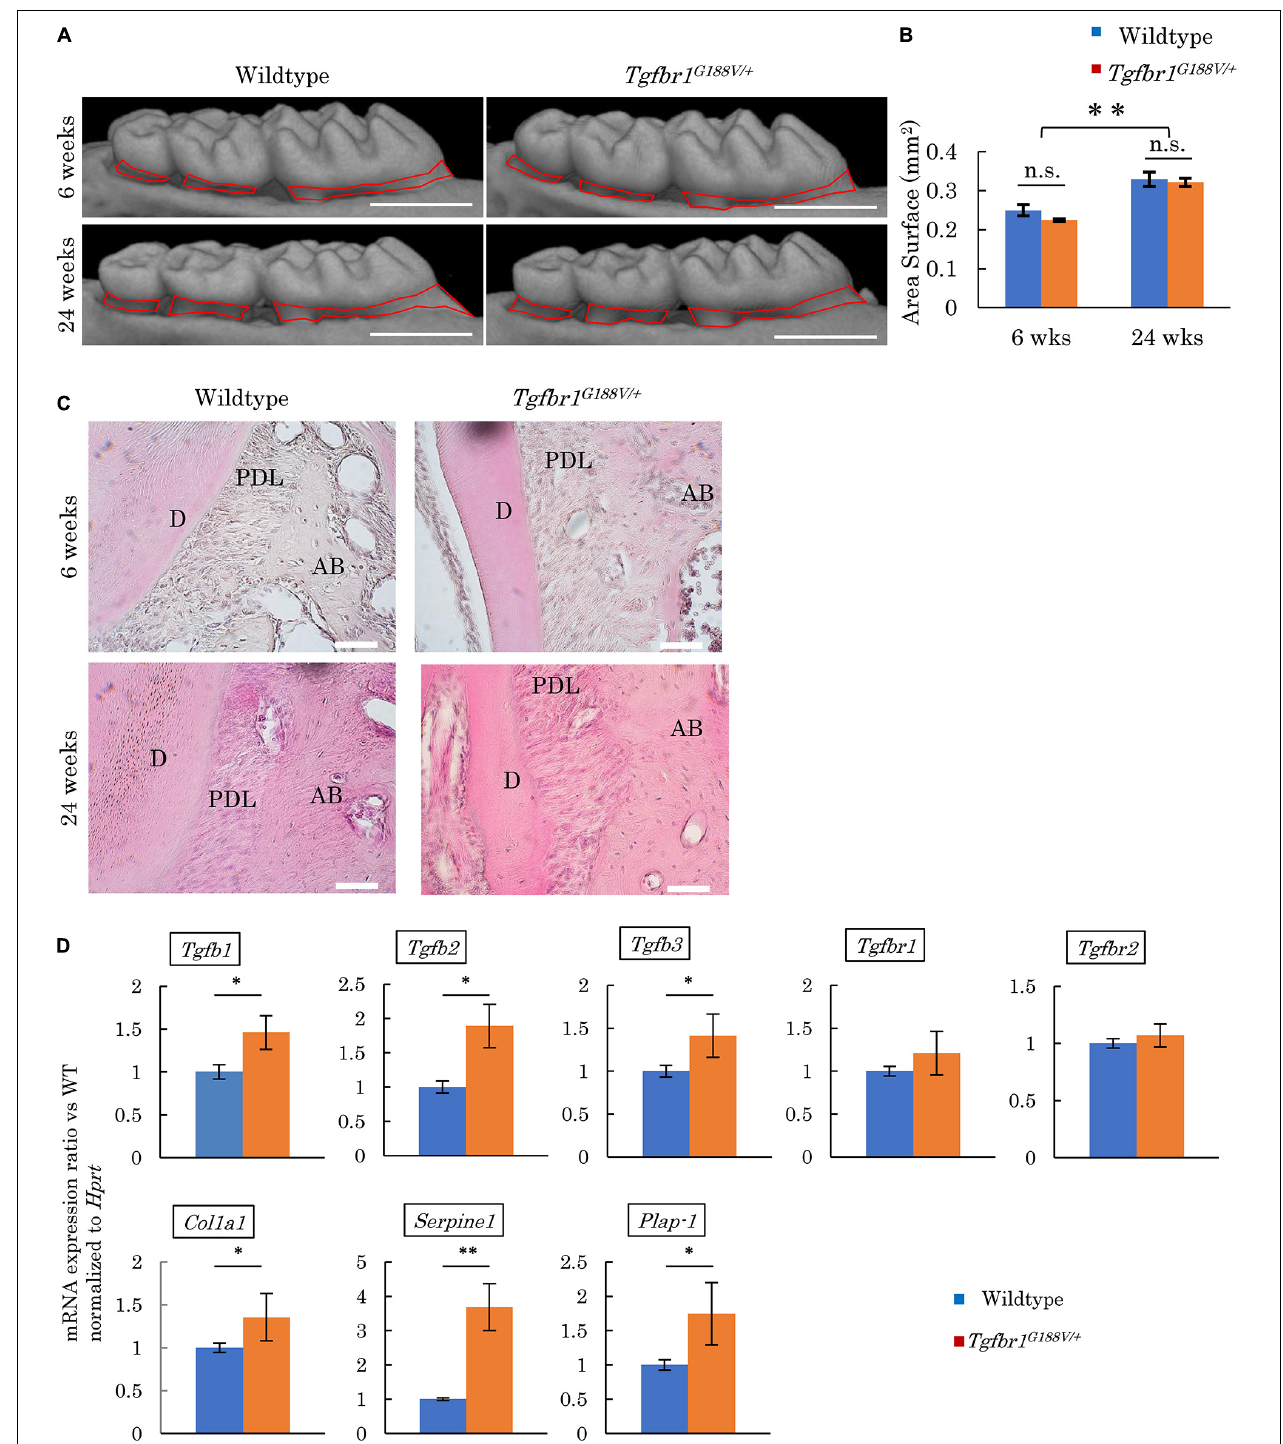
FIGURE 5 | Analysis of phenotypes in periodontal tissues of Tgfbr1 G 188 V / + mice. (A) Representative images from micro-CT analysis of maxillary alveolar bones in Tgfbr1 G 188 V / + mice. Scale bar: 1 mm. (B) Alveolar bone resorption was measured in the root surface area between the alveolar apex from the cementoenamel junction (red line in Figure 4A ). Data represent means ± SD. Six-week-old wildtype: n = 6, 6-week-old Tgfbr1 G 188 V / + : n = 8, 24-week-old wildtype: n = 20, and 24-week-old Tgfbr1 G 188 V / + : n = 14. (C) Representative images of HE staining of the periodontium from WT and Tgfbr1 G 188 V / + mice at 6 and 24 weeks of age. AB, alveolar bone; PDL, periodontal ligament; D, dentin. Scale bar: 50 µ m. (D) Analysis of TGF- β -related gene expression in periodontal tissues derived from wildtype and Tgfbr1 G 188 V / + mice ( n = 4). Data represent means ± SD in triplicate assays. ∗ P < 0.05, ∗∗ P < 0.01, compared with wildtype.